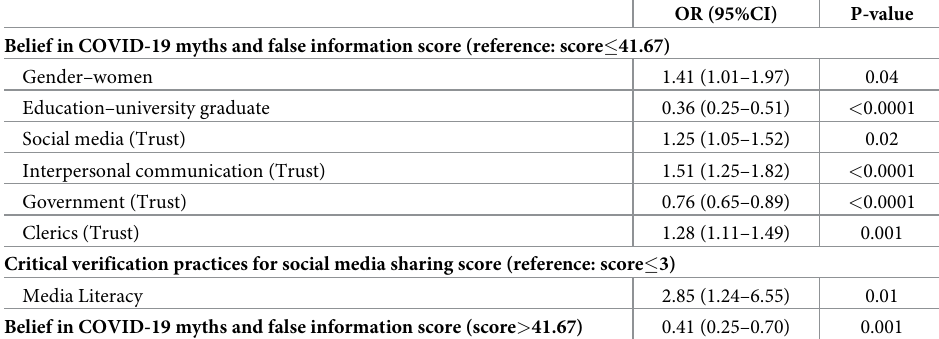
Table 4 presents the predictors of both outcomes: belief in COVID-19 myths and false information and engagement in critical verification practices for social media sharing. Those Table 4. Stepwise logistic regression of the predictors of the first (Belief in COVID-19 myths and false informa- tion) and second (critical verification practices for social media sharing) outcomes. OR (95%CI) P-value Belief in COVID-19 myths and false information score (reference: score � 41.67)